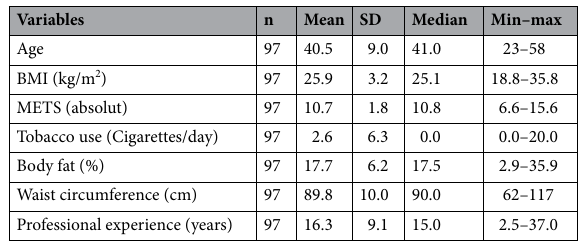
Table 1. Baseline characteristics of the participants. BMI Body mass index, METS metabolic equivalents.